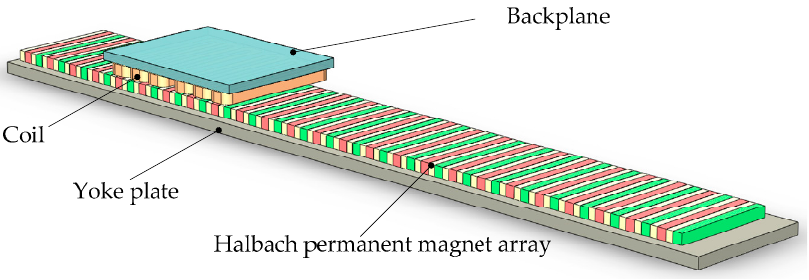
Figure 4. Basic structure of the proposed maglev linear motor. Energies 2018 , 11 , x FOR PEER REVIEW